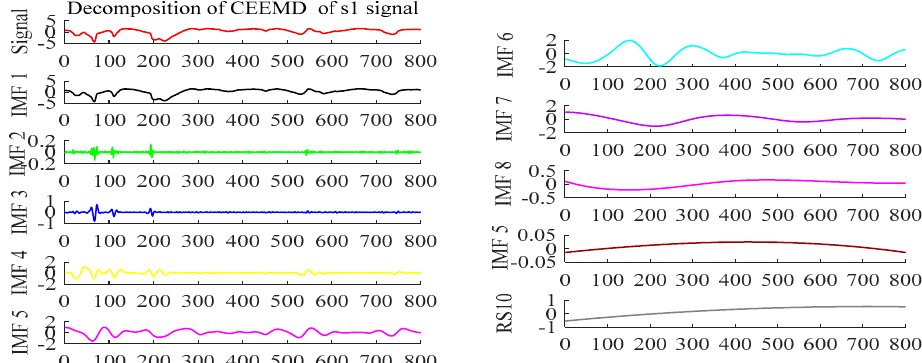
Figure 4. CEEMD decomposition IMF function and remainder.